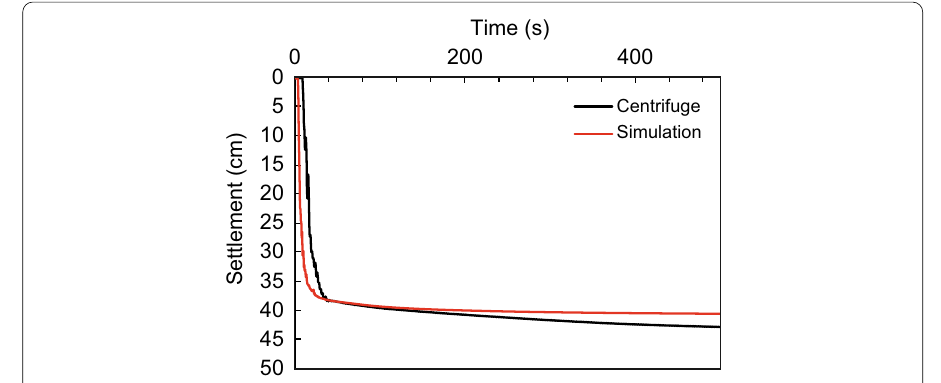
Fig. 10 Comparison of numerical and experimental results for settlement at top of the